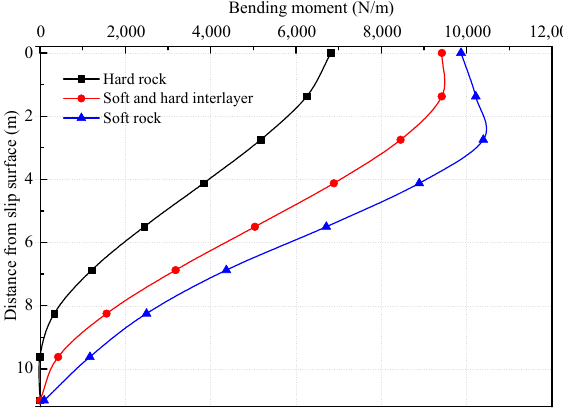
Figure 18. Bending moment distributions along the embedded section of the stabilizing pile.